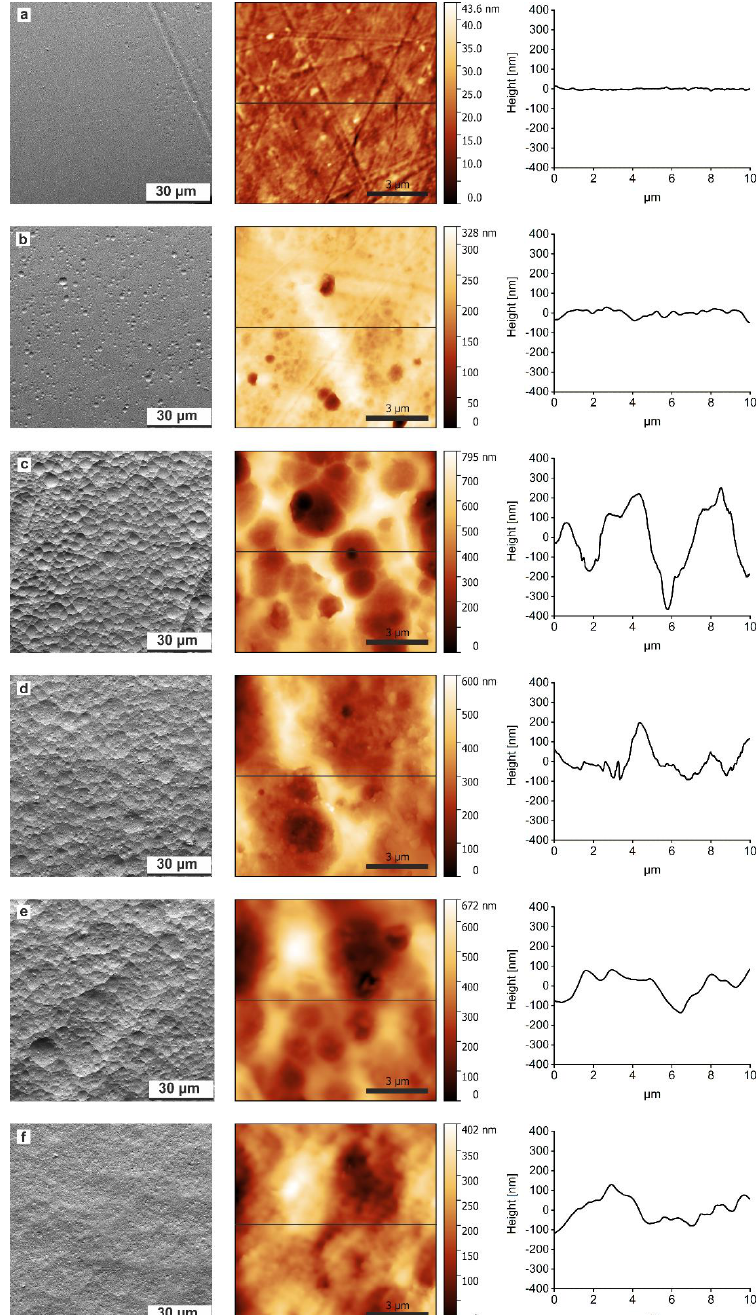
Figure 2. SEM (left column) and AFM (middle column) images with representative cross-sections (right column) of PLA: ( a ) untreated sample, ( b ) treatment with 1.0 mol/L NaOH for 120 min (2 h), ( c )